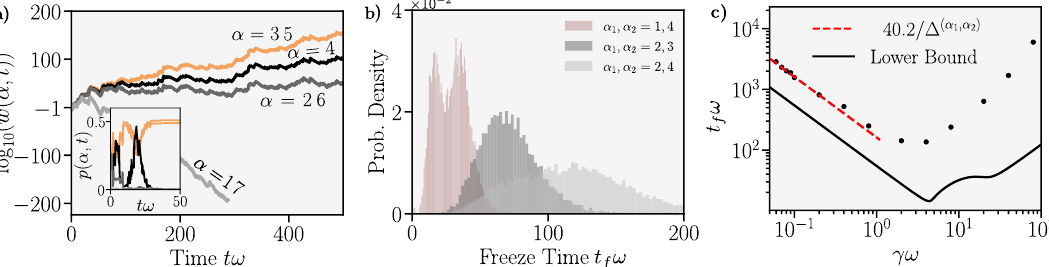
Figure 3: Freezing for coupled spin 3 / 2 particles governed by the GSKL equation with the Hamiltonian defined in Eq. (29) and a single jump operator L = s z set γ = 3 ω . The index α = 1,2,..7 refers to subspaces of total z magnetisation − 3 / 2, − 1,...,1,3 / 2 respectively. a) Logarithm of the un-normalised weight of a sin- gle trajectory — initialised in the form of Eq. (28) — versus time in each of the magnetisation subspaces. Inset) Normalised weight for t ω ≤ 50. b) Probability den- sity of the freeze-time t for 10 4 trajectories and for trajectories initialised in the form of Eq. (27) in the indicated subspaces with γ = 3 ω . c) Average freeze-time (black dots) vs γω on a log-log scale for trajectories initialised in the form of Eq. (27) with α = 2 and α = 3 respectively. Red dotted line shows the function 40.2 / ∆ ( α 1 , α 2 ) 1 2 whilst the black solid line shows the lower bound calculated via Eq. (24). We set ε = 10 − 6